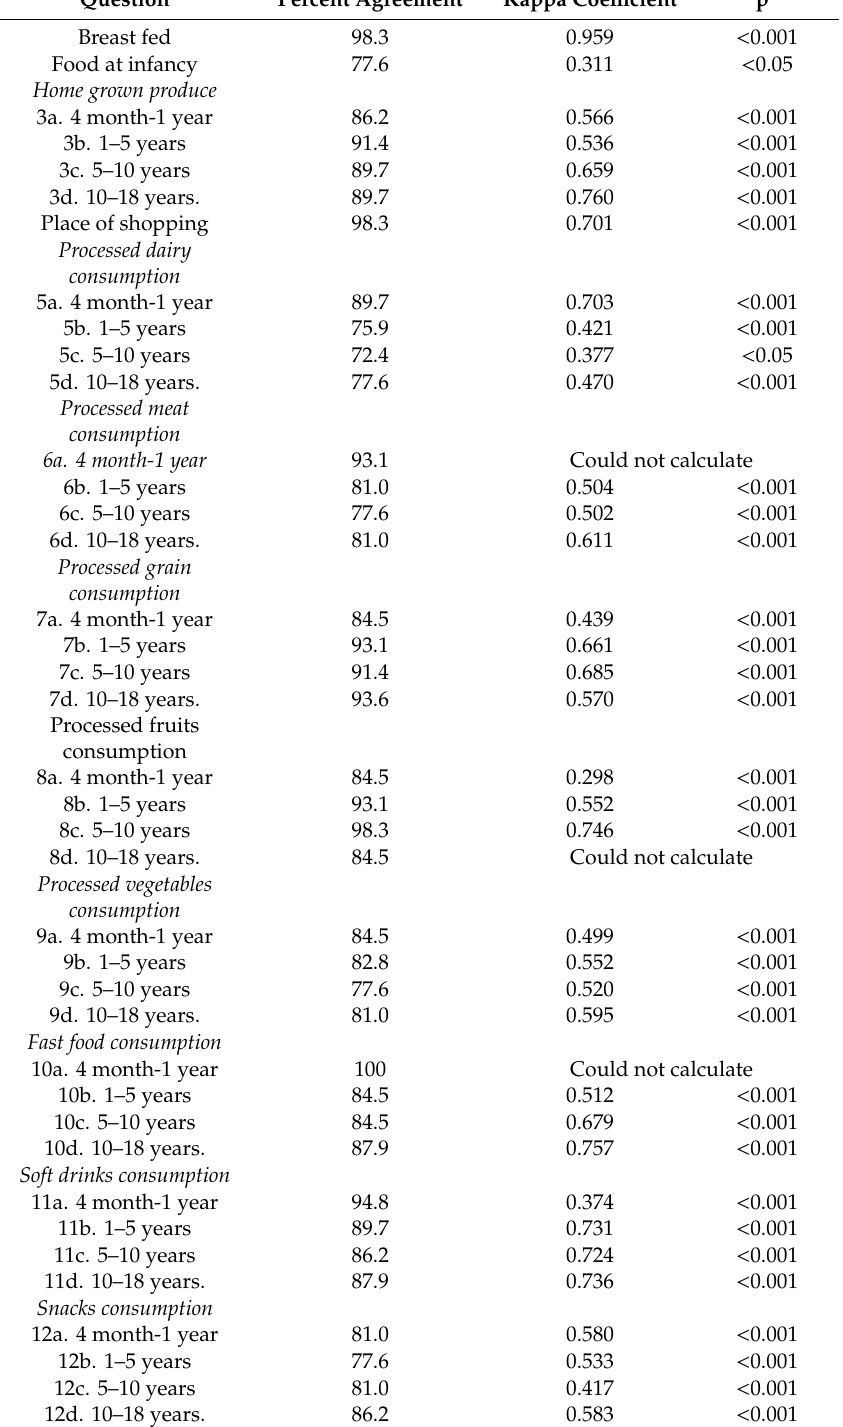
Table 4. Percent agreement and Kappa Coe ffi cient for items on part on